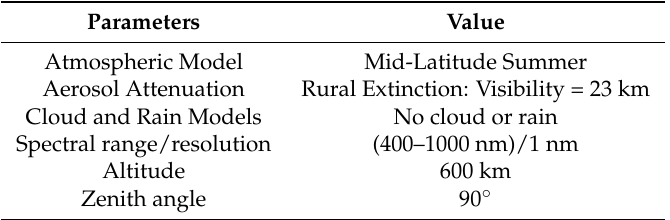
Table 2. The MODerate resolution atmospheric TRANsmission (MODTRAN) configuration